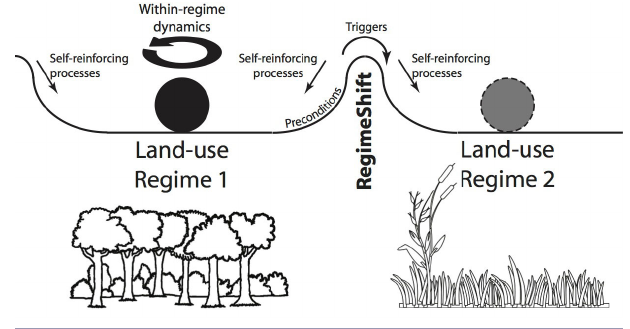
Fig. 2 . Framework for understanding land-use regime shifts. We distinguish between within-regime land-use dynamics and land- use regime shifts. Preconditions are the necessary conditions for a regime shift. Triggers are the immediate cause of the shift. Self-reinforcing processes maintain the new regime in a stable state, resisting a shift back to the old regime. Most land-change studies have focused on studying within-regime dynamics, and not the preconditions, triggers, and self-reinforcing processes governing regime